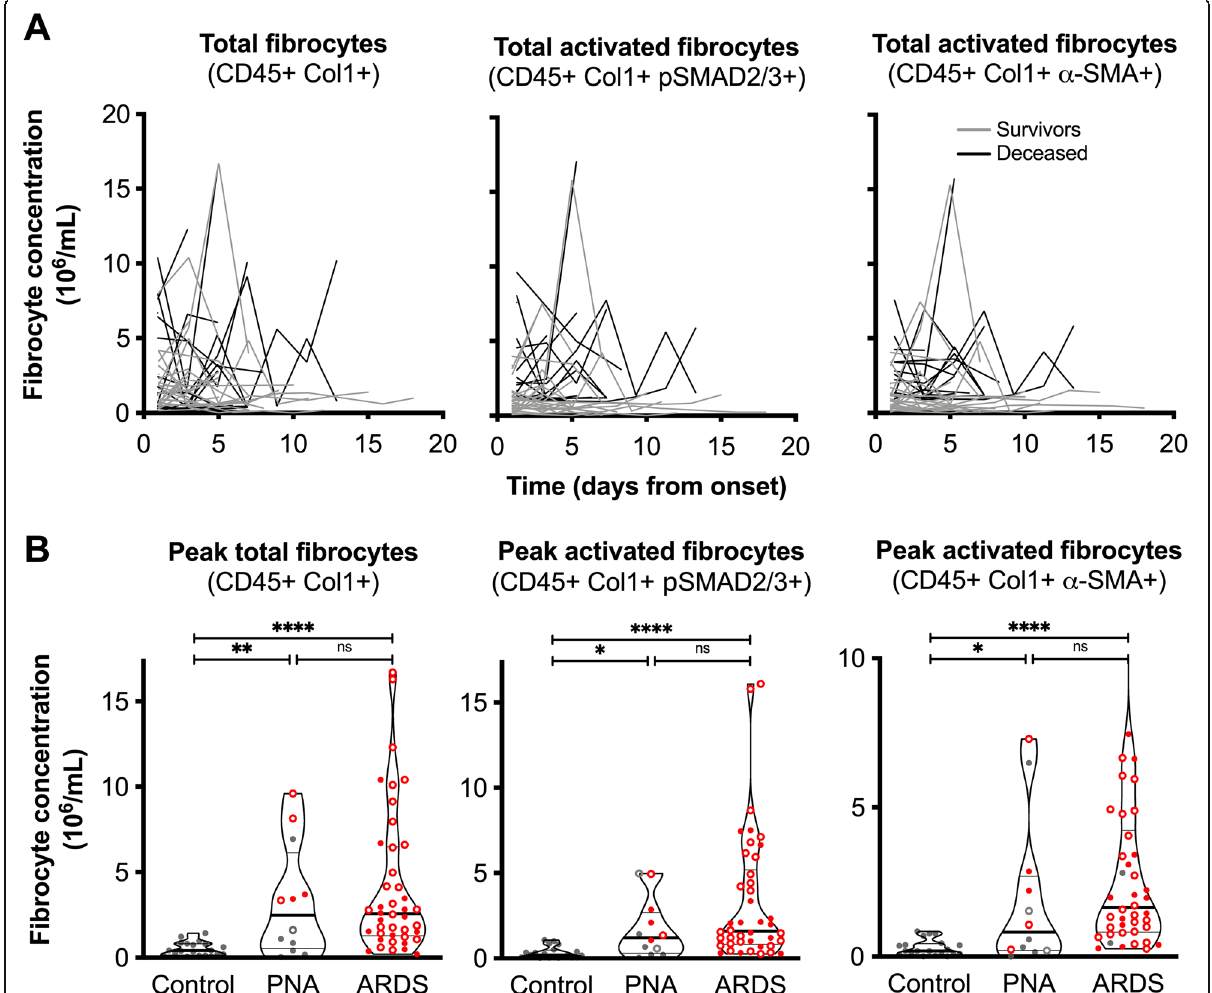
Fig. 3 Circulating fibrocytes in human pneumonia and ARDS. a Change over time in the number of total fibrocytes (CD45+ Col1+) and activated fibrocytes staining for phosphorylated SMAD-2 or − 3 (CD45+ Col1+ pSMAD2/3+) or expressing alpha-smooth muscle actin (CD45+ Col1+ α - SMA+) during the course of ARDS. Each line represents one subject. b Comparison of peak total fibrocytes (CD45+ Col1+) and activated fibrocytes (CD45+ Col1+ pSMAD2/3+ and CD45+ Col1+ α -SMA+). Each dot represents one subject; bold horizontal lines indicate the median, and light horizontal lines represent the 25th and 75th percentiles. Red dots indicate patients that required mechanical ventilation; open dots indicate patients that required vasopressor support. *, p < 0.05; **, p < 0.01, ****, p < 0.0001 by Kruskal-Wallis